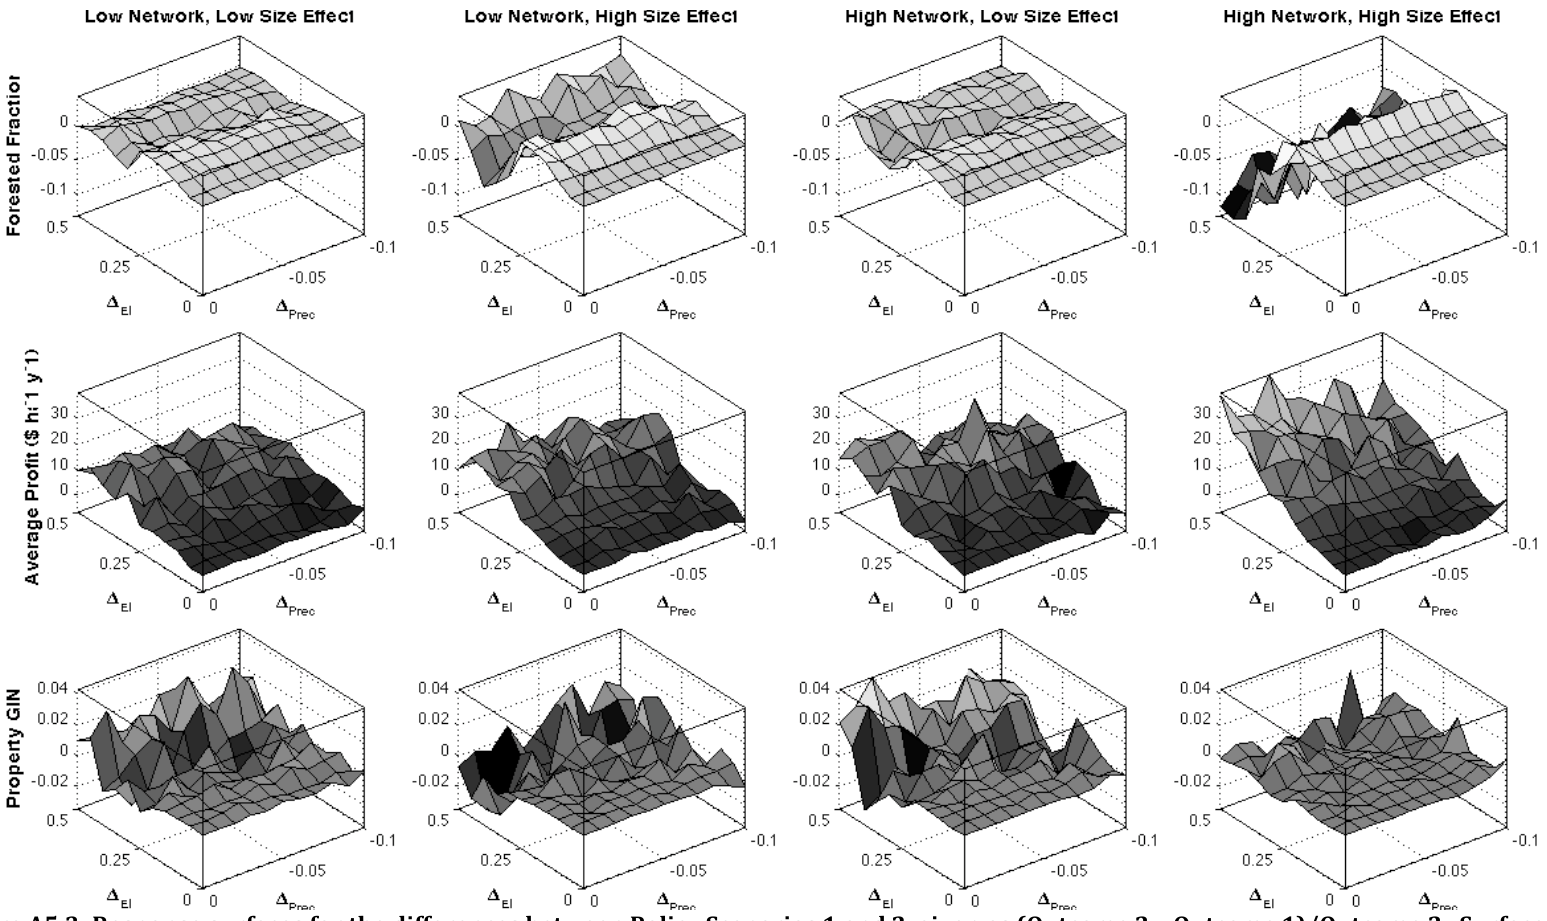
Figure A5.3: Response surfaces for the differences between Policy Scenarios 1 and 2, given as (Outcome 2 – Outcome 1)/Outcome 2. Surfaces in row 1 show difference in average forested fraction across the landscape; row 2 shows difference in average profit per hectare of property per year; row 3 shows difference in the level of land aggregation measured by the property GINI coefficient. Each column represents a different scenario of rancher